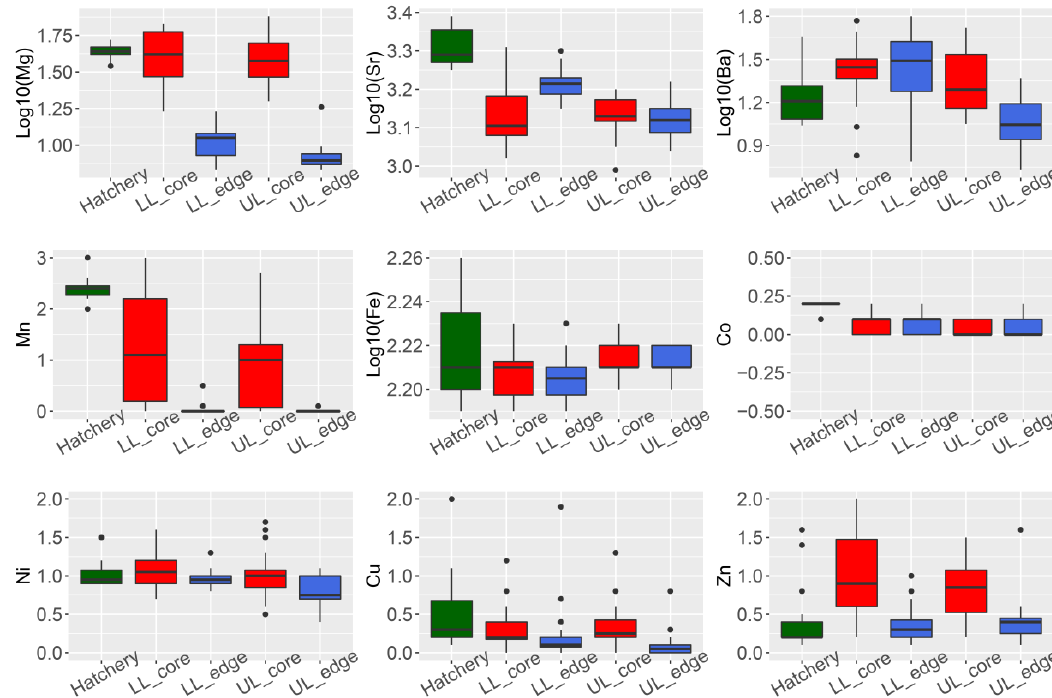
Figure 2. Summary of trace element composition (ug · g − 1 ) in otoliths of Macquaria ambigua (golden perch) from three localities. Hatchery = hatchery sourced YOY samples (n = 19). LL = samples from the lower Lachlan (downstream Lake Brewster) (n = 24); UL = samples from the upper Lachlan (upstream Wyangala Dam) (n = 20); core = measurements from the core of the otolith; edge = measurements from the edge of the otolith.